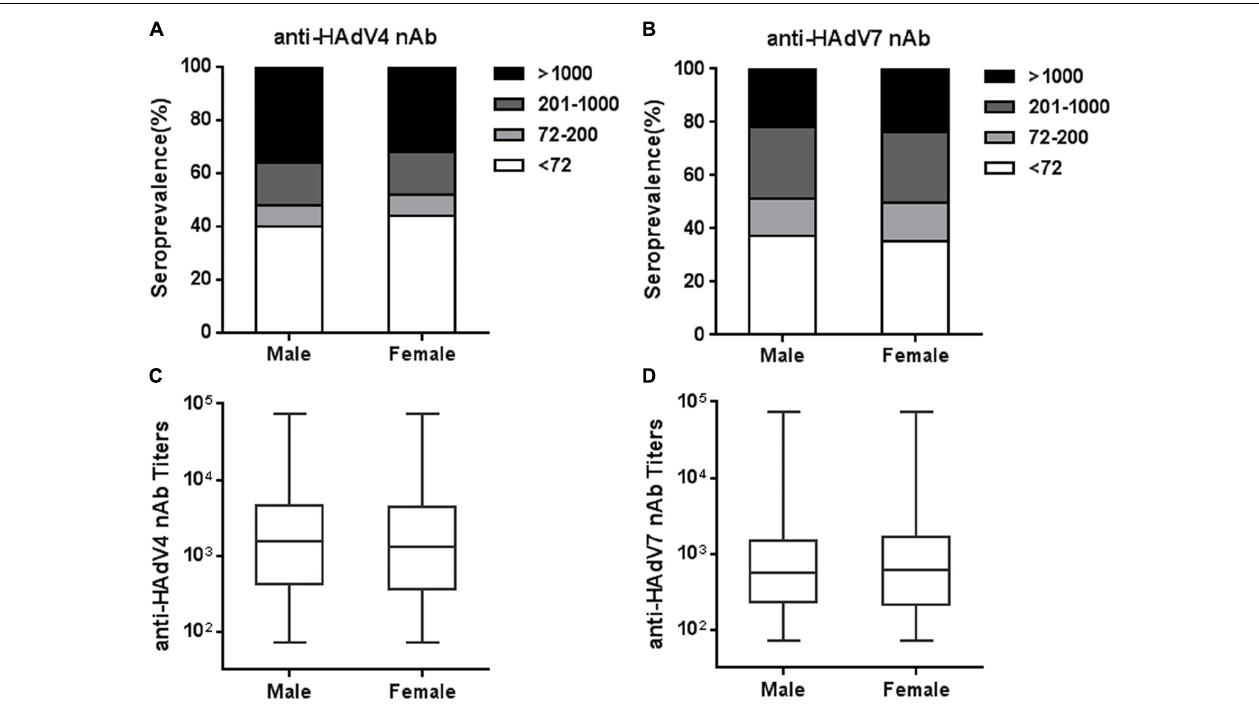
FIGURE 4 | Seroprevalence and titer distribution of anti-HAdV4 nAb and anti-HAdV7 nAb in sex groups. (A,B) The distributions of anti-HAdV4 nAb (A) and anti-HAdV7 nAb (B) titers in sex groups. (C,D) The titers of nAb to HAdV4 (C) and HAdV7 (D) in seropositive males and females. The data were analyzed using the Mann-Whitney